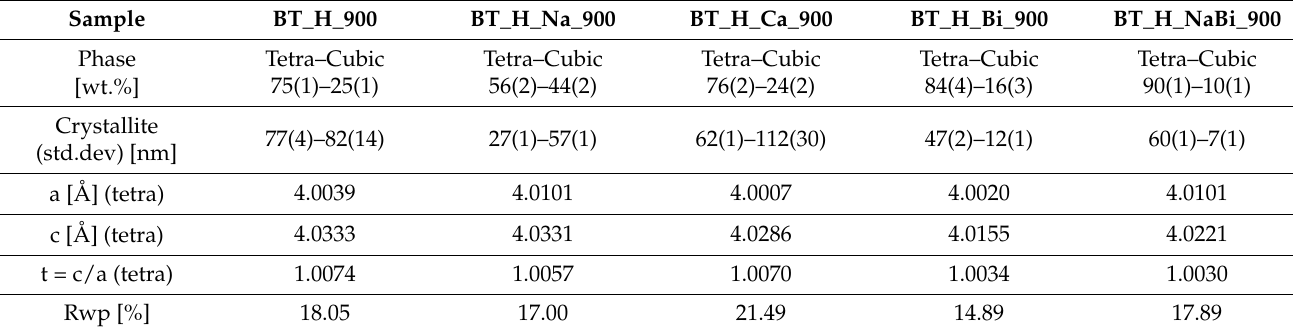
Figure 11. XRD patterns of doped BaTiO 3 samples: BT_H_Na_900 (black line), BT_H_Ca_900 (red line), BT_H_Bi_900 (blue line), and BT_H_NaBi_900 (pink line). Inset: BT_H_Bi_900 pattern shown in log scale to highlight the presence of secondary phase traces. Table 6. Quantitative phase analysis, crystallite size, and lattice parameters of doped BT powders.